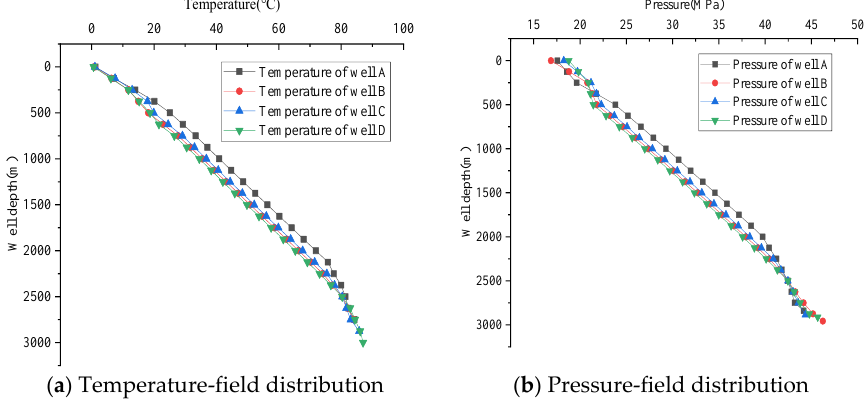
Figure 5. Temperature and pressure distributions of CO 2 injection strings.